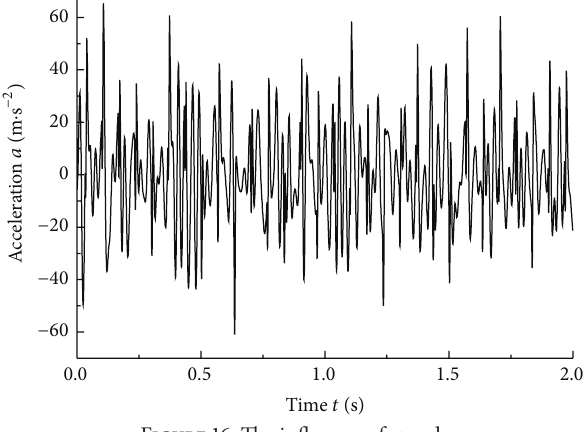
Figure 16: The influence of